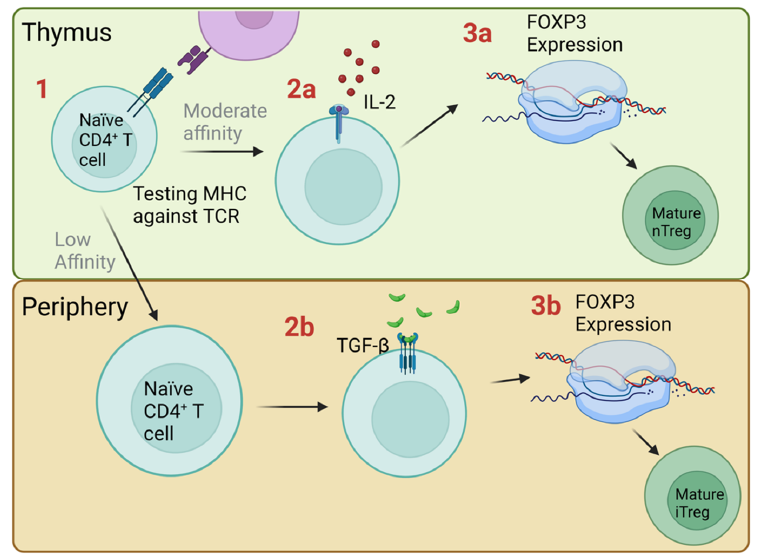
Figure 2. Treg development in the thymus and periphery. ( 1 ) Naïve CD4 + T cells in the thymus test their